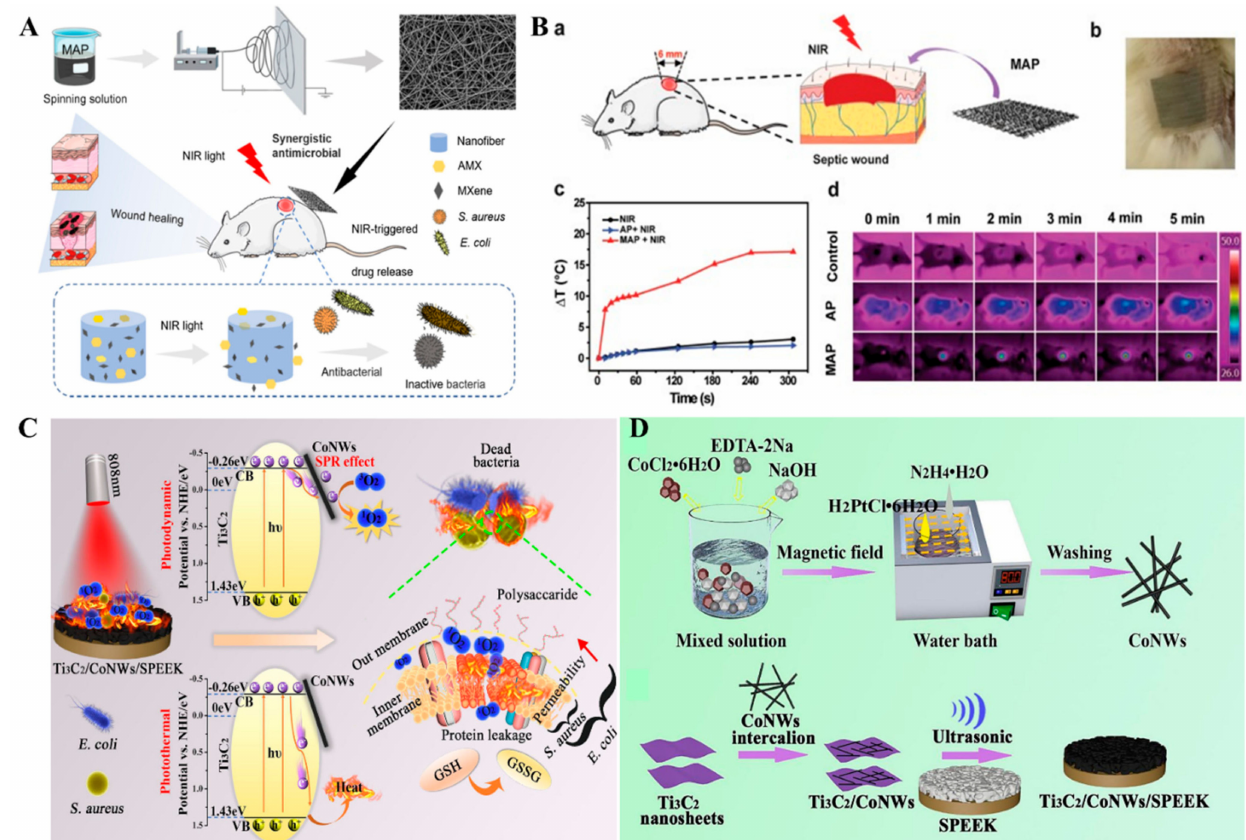
Figure 4. ( A ) Schematic illustration of the fabrication of MAP nanofibrous membrane for antimi- crobial therapy. ( B ) A model of the Balb/c mice infected with S. aureus ( a ); An image of the an- tibacterial dressing using the MAP nanofibrous membrane ( b ); NIR-induced temperature increase in the S. aureus -infected mice wounds ( c ), and the corresponding thermal images ( d ). Reprinted with permission from Ref. [91]. Copyright © 2021 Elsevier. ( C ) Schematic diagram for the NIR- activated antimicrobial mechanism of Ti 3 C 2 T x /CoNWs/SPEEK. ( D ) Synthesis process for the coating of Ti 3 C 2 T x /CoNWs heterojunction on porous SPEEK. Reprinted with permission from Ref. [92]. Copyright © 2021